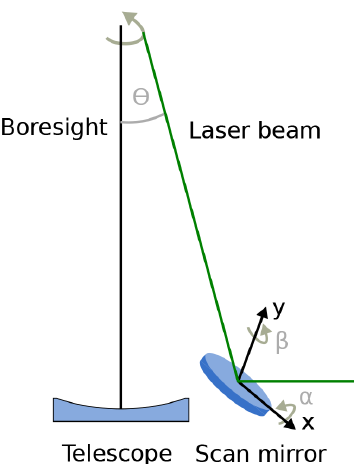
computes the beam position. Any deviation from the prede- termined target position is nulled by a servo loop. The tar- get needs to be found by other means, e.g., manual search.